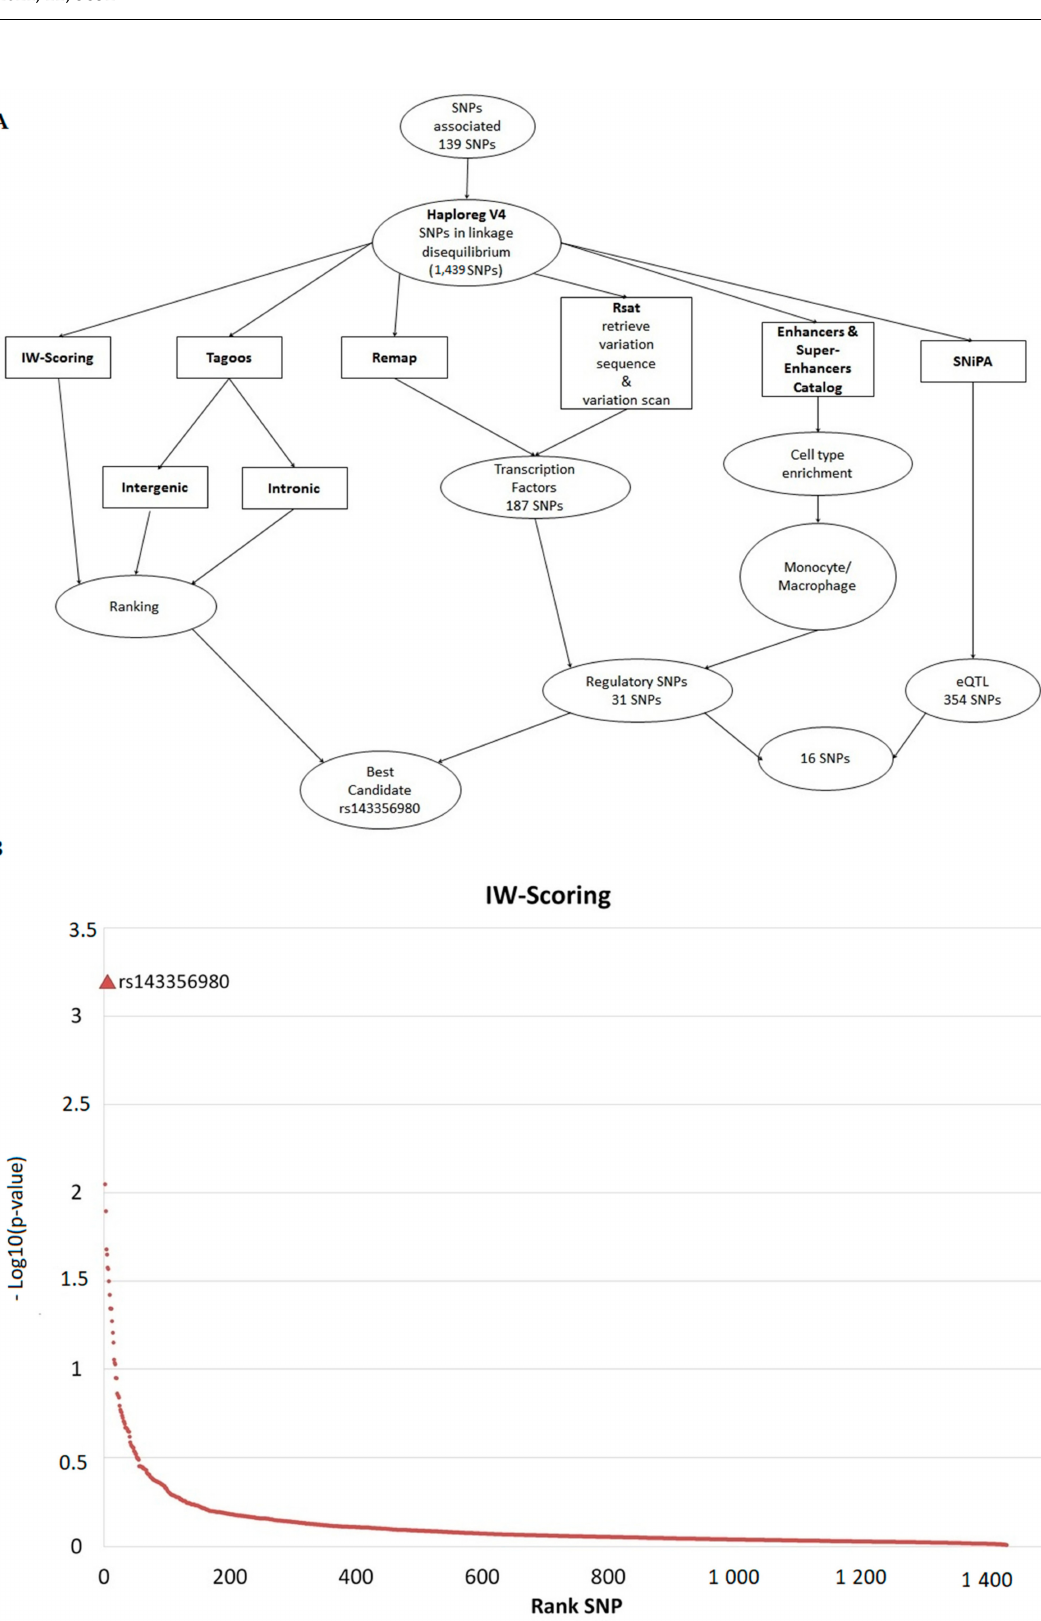
Figure 4. Schematic outline of non-coding SNP annotation and prioritization. ( A ) Schematic outline of non-coding SNP annotation and selection. SNiPA was used for looking for eQTL, whereas RSAT and ReMap were used for identifying transcription factors binding sequences containing the SNPs. Enhancer and super-enhancer annotation was based on the catalog published by Hnisz [33]. IW-scoring and TAGOOS methods were applied to rank the SNPs. ( B ) Prioritization of non-coding SNPs on the basis of IW-scoring